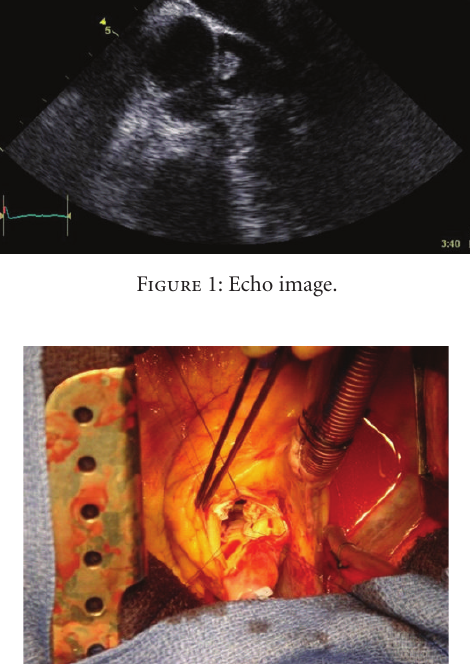
Figure 2: Perioperative view.